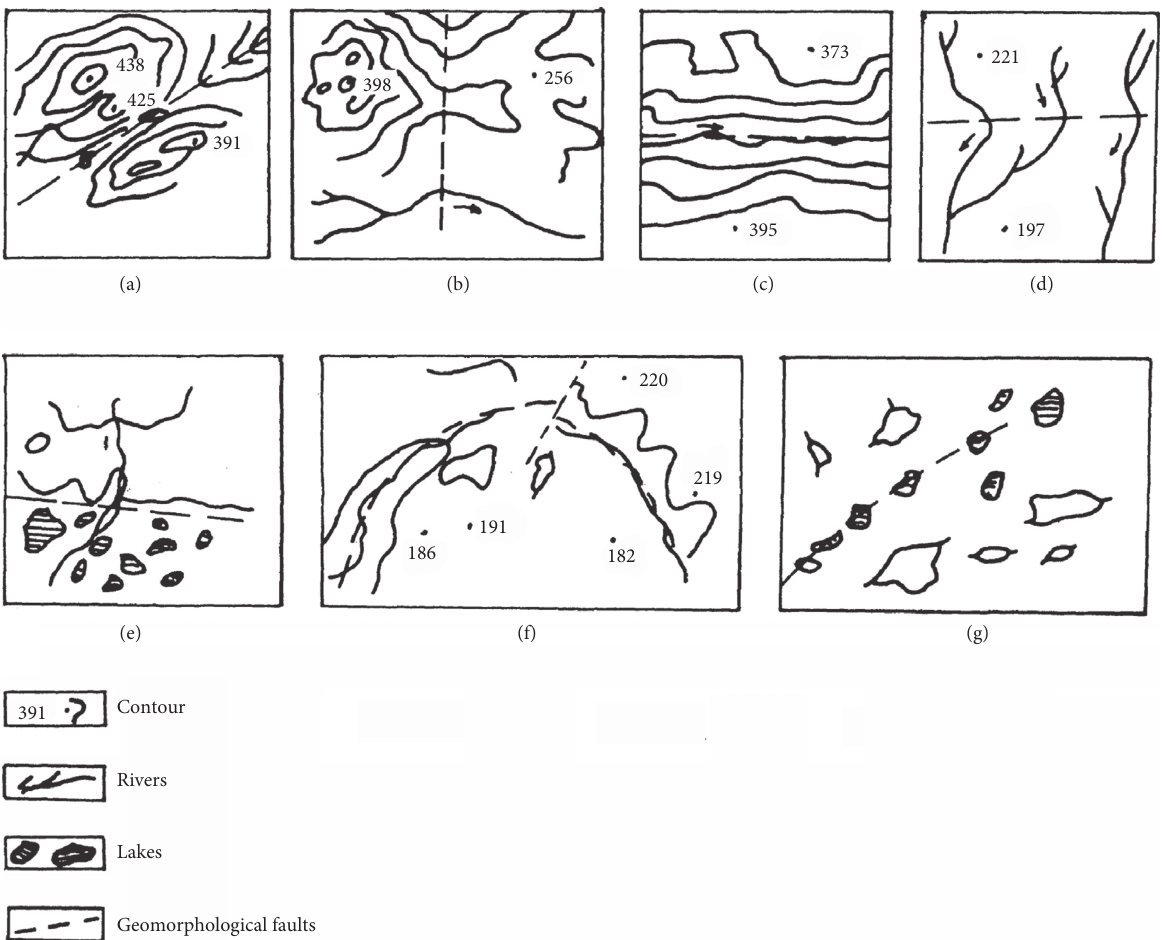
Figure 2: Geomorphological characteristics of fault structures: (a) contour drop; (b) geomorphology and riverbed changes; (c) inter- mountain canyons; (d) bending trend of rivers; (e) landscape characteristics; (f) valleys with special contour; (g) lakes of linear